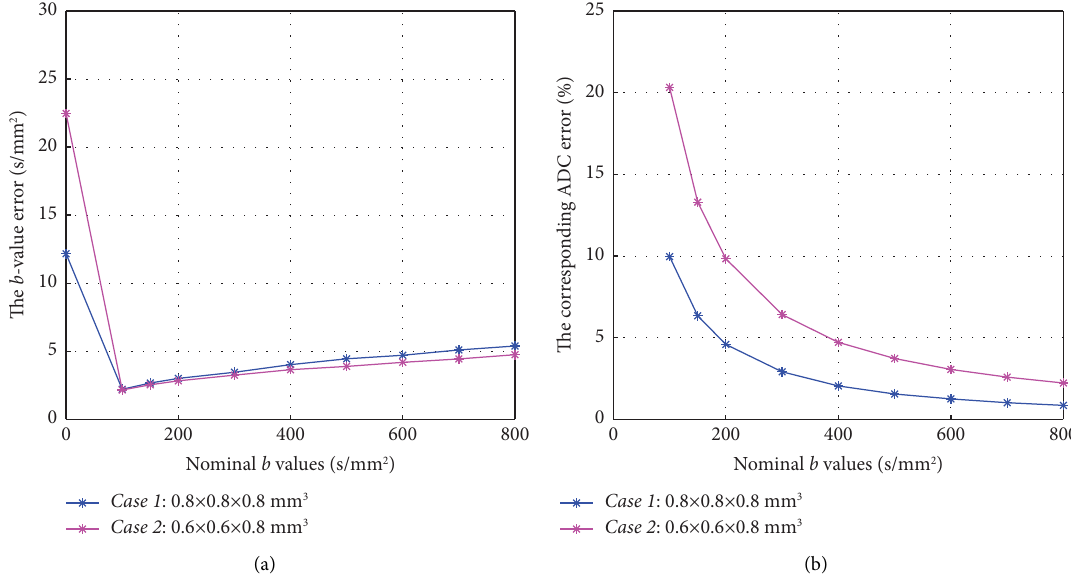
Figure 6: Te b -value error (caused by ignoring the contribution of imaging gradients) (a) and the relationship between the choice of b - value and the (b). that in ADC is calculated as ADC error � ( ADC acc − ADC nom / ADC acc ) × 100% � ( 1 − ( b acc − b acc nominal